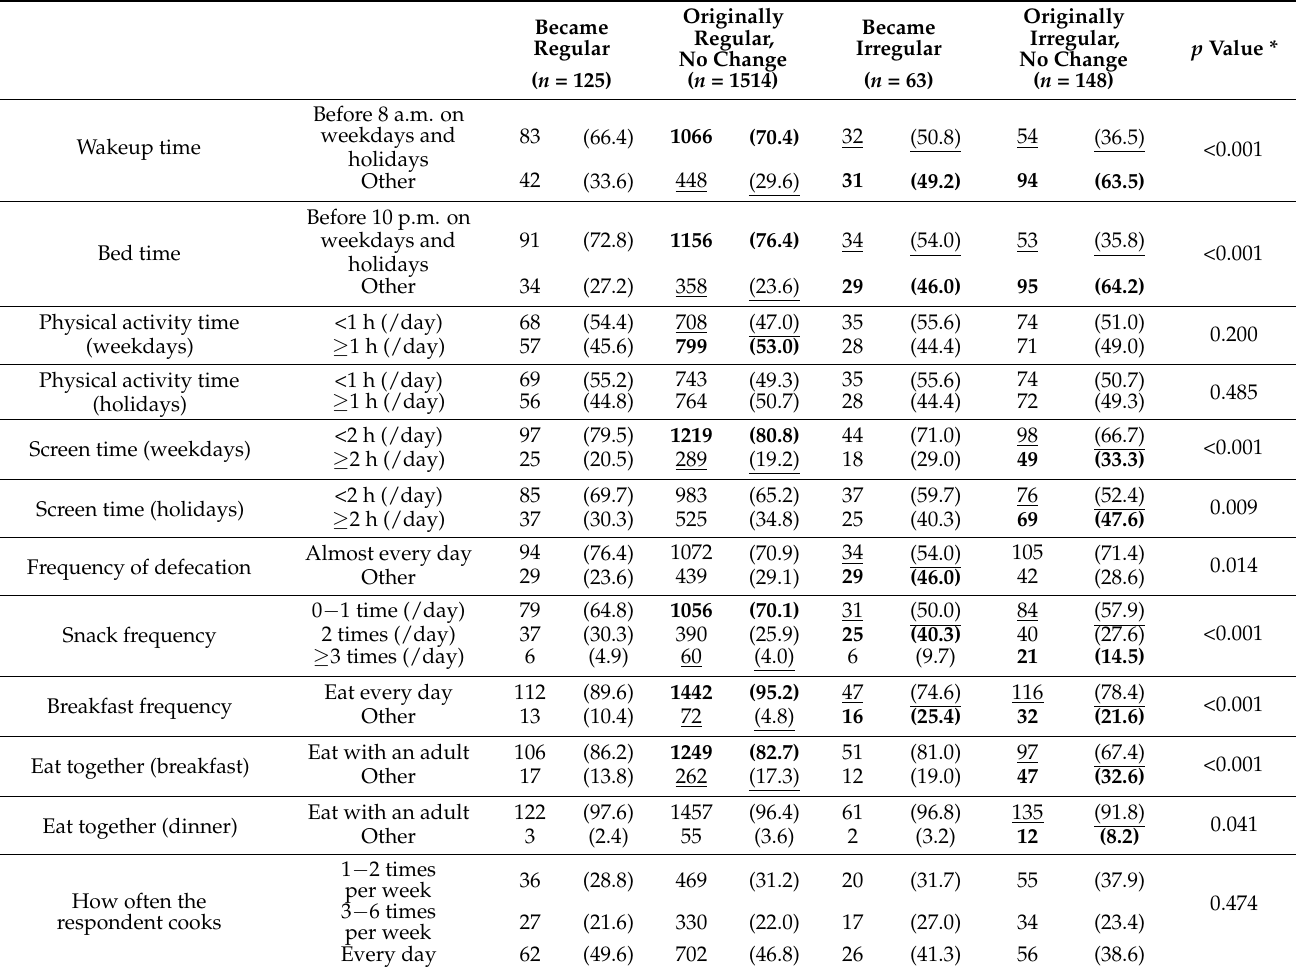
Table 2. Lifestyle habits and household circumstances according to changes in mealtime regularity compared with before